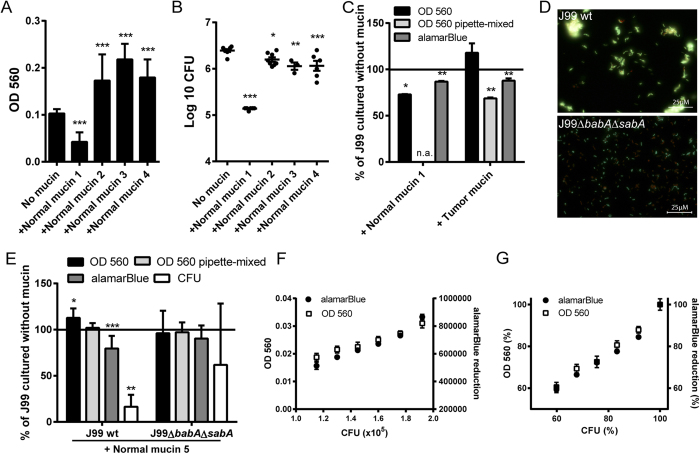
Proliferation and viability in response to different mucins.(A) OD560 of liquid cultures of H. pylori J99 cultured for 60 h with purified human gastric mucins from several individuals. H. pylori were still in the growth phase at this time point (i.e. had not entered the stationary phase). (B) CFU count of H. pylori J99 cultured for 60 h with human mucins. (C) Comparison between metabolic activity, measured as reduced alamarBlue, and OD560 of H. pylori J99 cultured for 24 h with or without the normal mucin sample 1 (does not induce formation of aggregates, but carries the α1,4-GlcNAc structure that has antibiotic like properties) and the tumor mucin sample (induce formation of aggregates and does not carry α1,4-GlcNAc). Cultures were shaken or pipette-mixed prior to OD560 measurement. Values are shown as percentage of J99 cultured without mucins (represents 100%), n.a. = not analyzed. (D) LIVE/DEAD BacLight staining of the J99 wt and J99ΔbabAΔsabA deletion mutant after culture with Leb-positive mucins isolated from a normal stomach (normal mucin 3). Live bacteria are colored green and dead bacteria are colored red. (E) Comparison between OD560 measurements, metabolic activity and CFU counts for J99 wt and J99ΔbabAΔsabA deletion mutant after culture with Leb-positive mucin sample 5. Values are shown as percentage of each strain cultured without mucins (represents 100%). (F) The relationship between the alamarBlue signal, CFU counts and OD560 in the absence of mucin. (G) The relationship between the % change in alamarBlue signal at OD560, CFU counts and OD560 in the absence of mucin (100% corresponds to the highest value in (F). All values are presented as mean ± S.E.M, *p ≤ 0.05, **p ≤ 0.01, ***p ≤ 0.001: statistical tests were performed with ANOVA with Dunnett’s post hoc test, except the CFU data in panel E, which was analyzed with the Mann-Whitney U test.